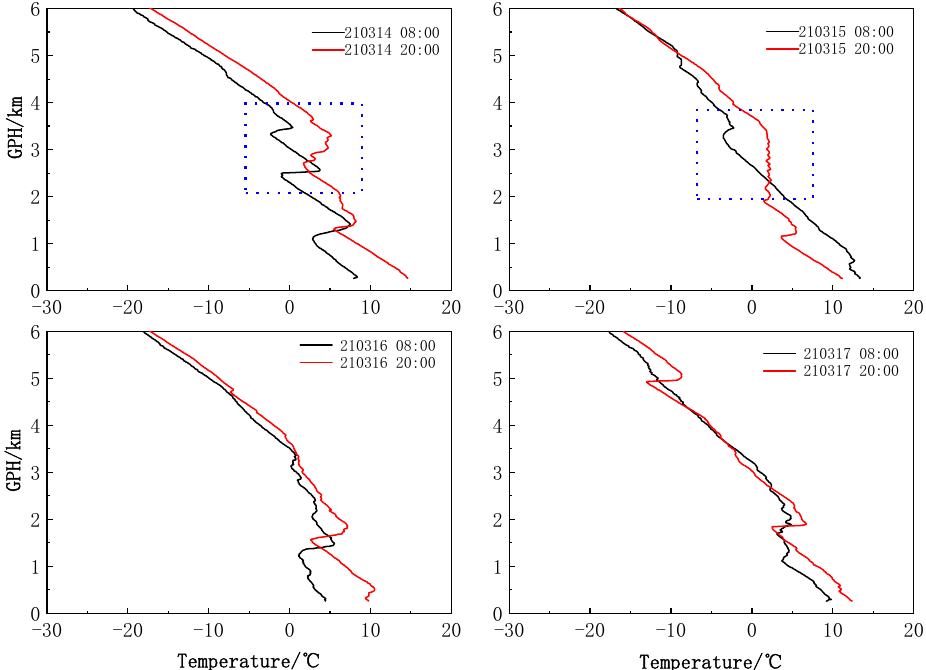
Figure 14. Vertical profile of the atmospheric temperature, the longitudinal coordinate of the figure is the GPH (geopotential height).